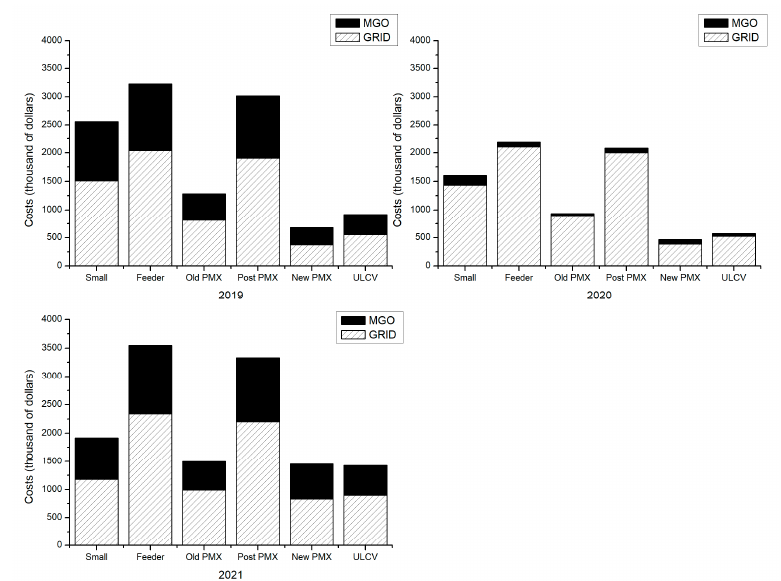
Figure 2. Cost differences in fuel oil and electricity prices (MGO).